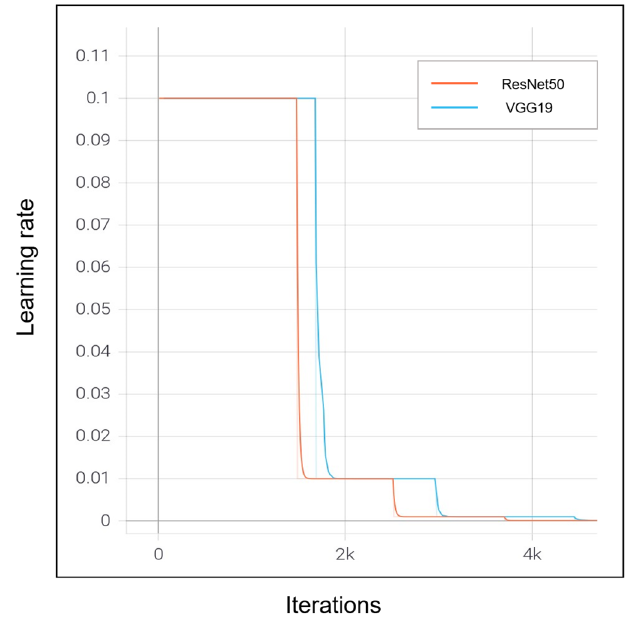
Figure 8. Learning rate change plots for VGG19 and ResNet50 models.